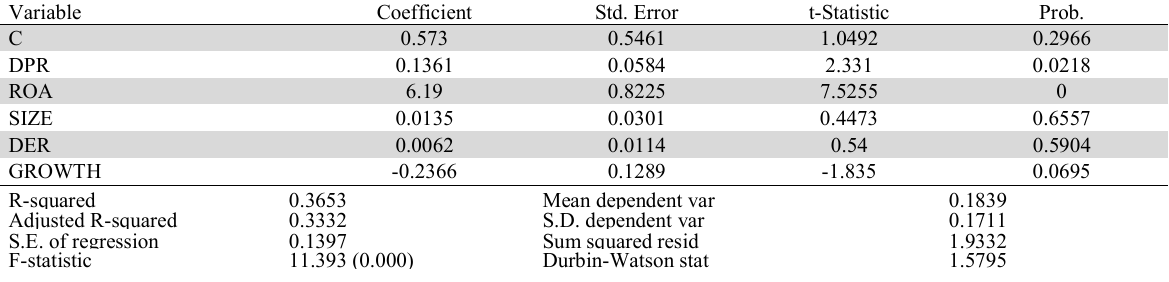
Results of the Estimated Random Effect